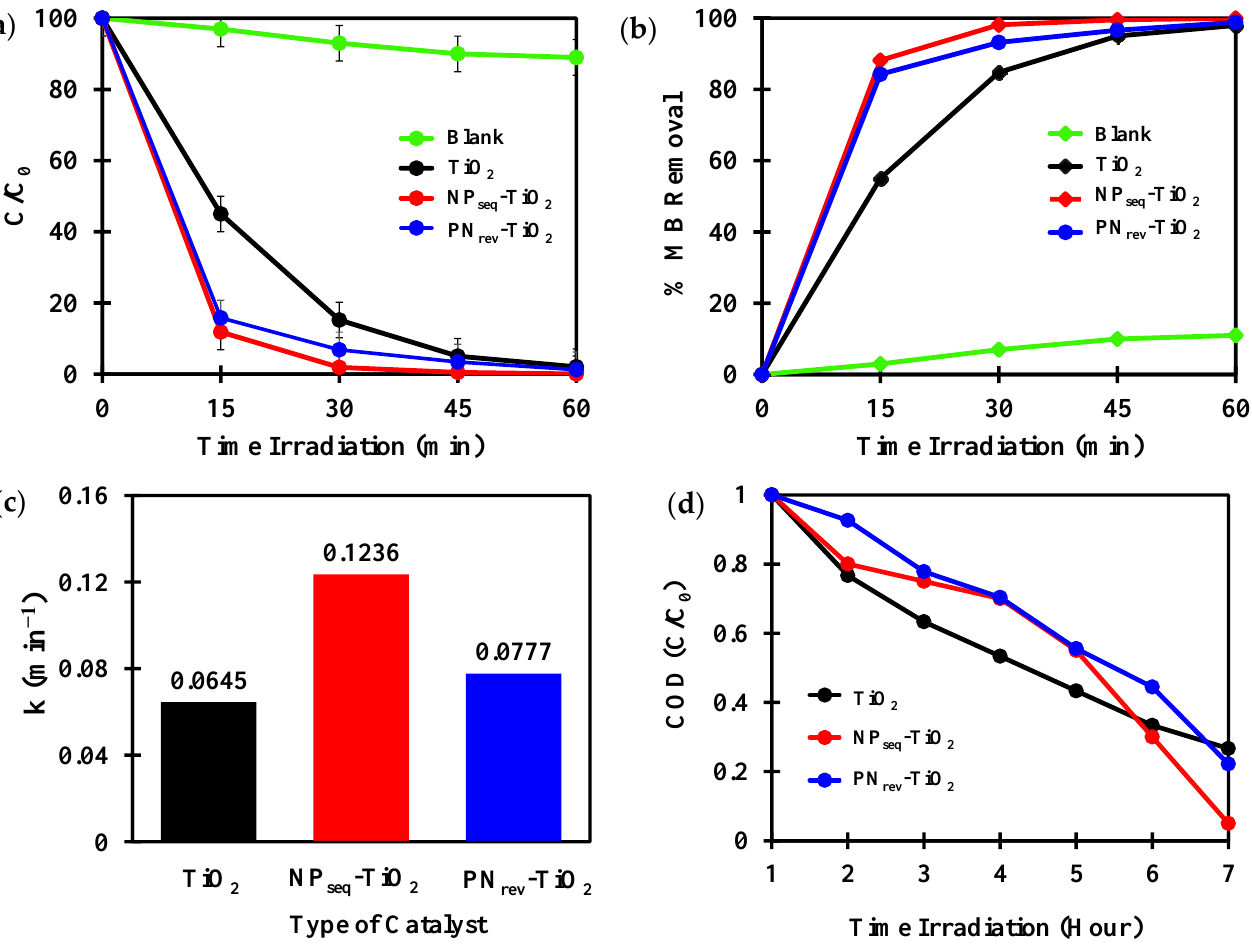
Figure 9. ( a ) The percentage remaining of MB dye; ( b ) the percentage removal of MB dye; ( c ) the rate constant, k; ( d ) the chemical oxygen demand for TiO 2 , NP seq -TiO 2 , and PN rev -TiO 2 photocata- lysts.